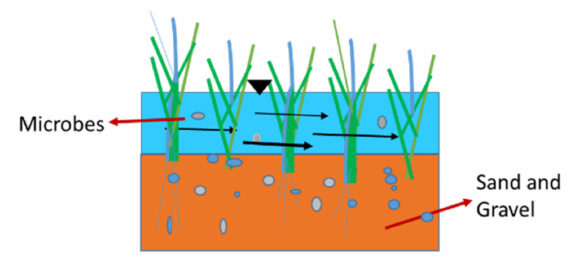
Figure 1. Schematic layout of free surface flow.